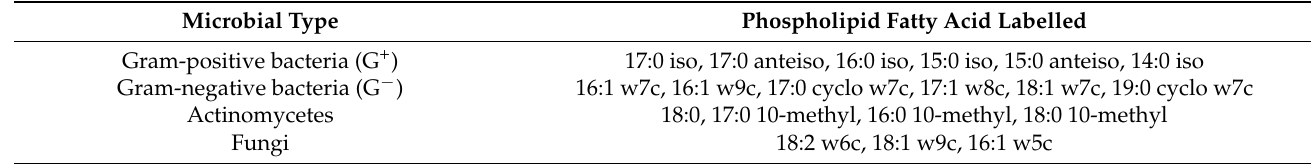
Table 3. Phospholipid fatty acid (PLFA) characterization of